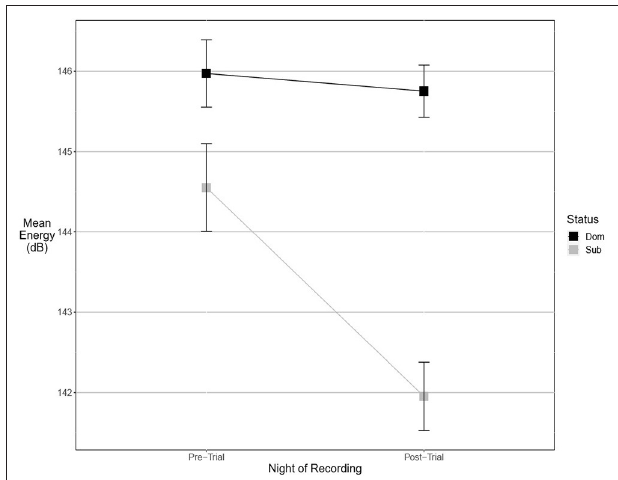
FIGURE 5 | Dominant males signal with higher energy than subordinate males. This margin is significant after an aggressive interaction. Graph of mean estimates of model: Energy ∼ (1|ID) + (1|Pair) + Score Result *Night of